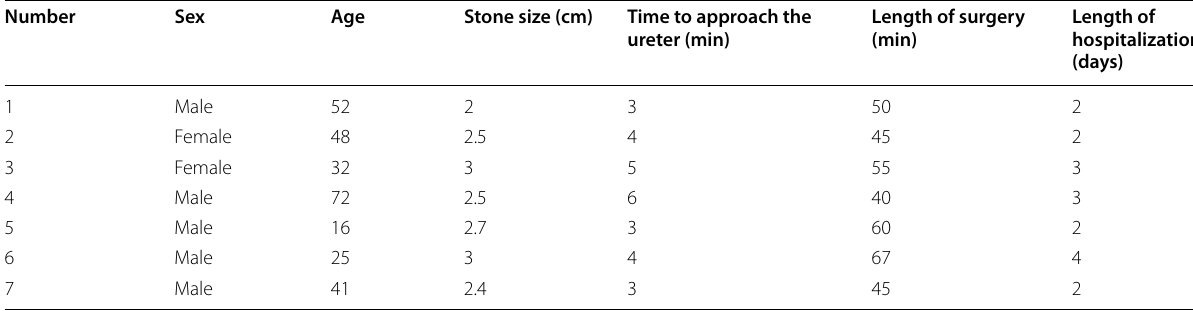
Table 1 All data of each